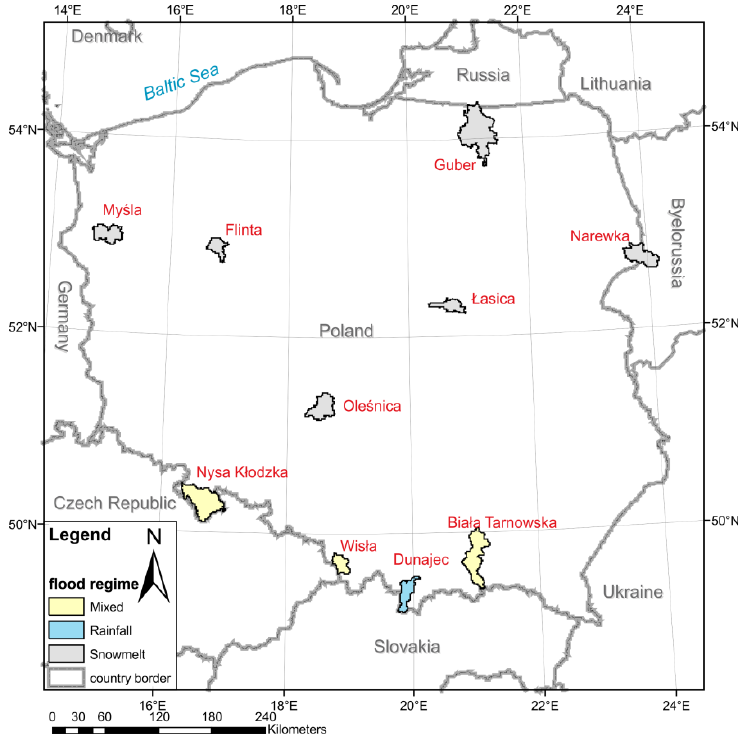
Figure 1. The location of the selected catchments in Poland.